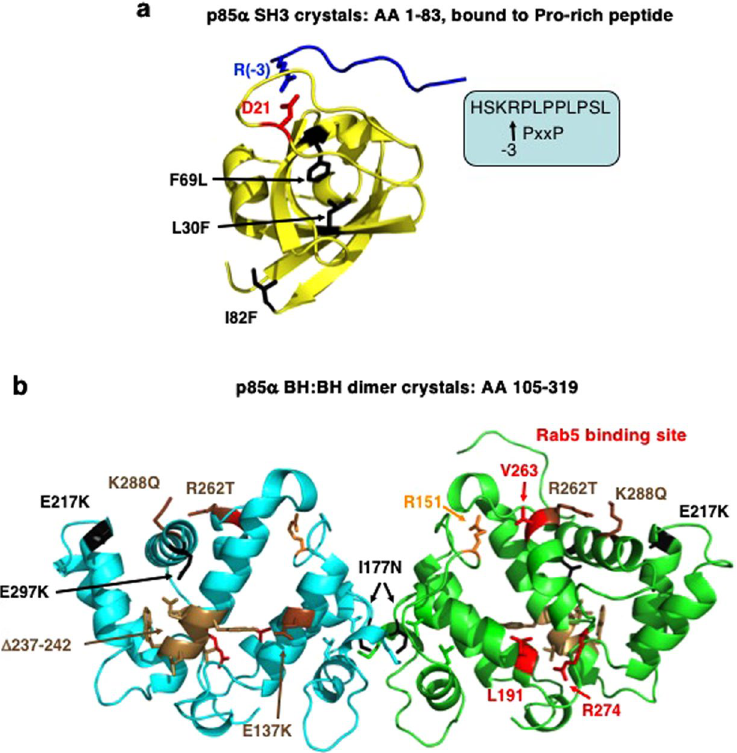
Figure 5. Structures and locations of key residues within the SH3 and BH domains of p85 α . ( a ) The human p85 α SH3 domain with endometrial cancer-associated mutations shown (black) in relation to D21 (red) important for binding to proline-rich peptides containing a key arginine residue (blue) 53 . ( b ) The bovine p85 α BH domain showing the residues that are important for Rab5 binding (red) and Rab5-GAP activity (red, orange). Endometrial cancer patient-derived mutations (black) and bladder cancer-associated mutations (brown) are also shown, including an in-frame deletion ( Δ 237–242), which was too unstable to purify. I177 (black) is both involved in BH–BH domain dimerization within the crystal structure and is a residue mutated in endometrial